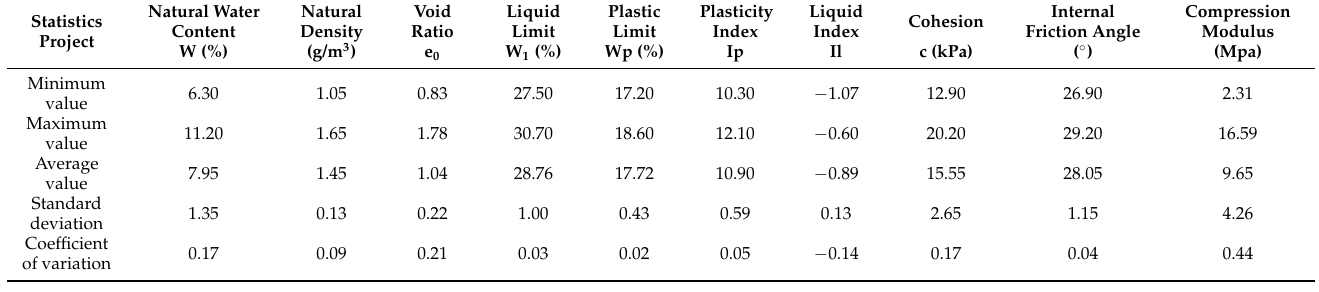
Table 1. Statistical table of physical and mechanical indicators of loess in the Quaternary Upper Pleistocene (Q 2 eol ).